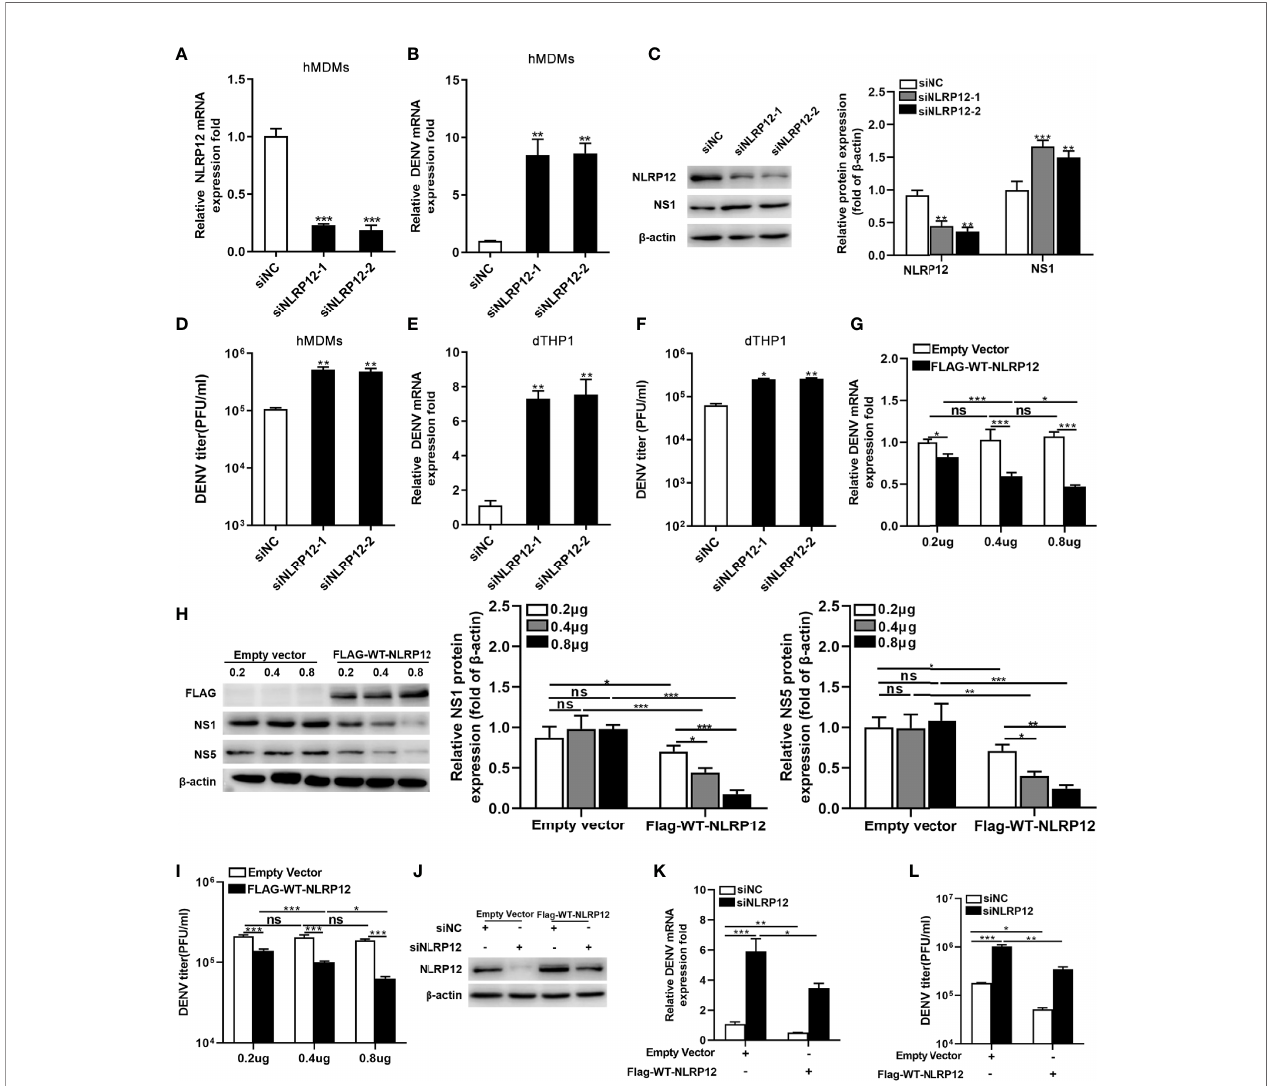
FIGURE 3 | NLRP12 inhibited DENV replication in vitro . (A) hMDMs were transfected with control siRNA or NLRP12 siRNA and the RNA silencing ef fi ciency ofNLRP12 was shown. (B, C, D) NLRP12- silenced hMDMswere infectedwith DENV at a MOI of4 for 48h,after which the DENV genome RNA levelswere detected byqPCR and protein levelsof NS1 were assessed respectively bywesternblot. The gray value ofNS1 proteinbandswas analyzedby Image J gelimage analysis software and the relative grayscalevalue was normalized to that of b -actin. The viraltiter insupernatant was quanti fi ed byplaqueassay. (E,F) dTHP-1 cellswere transfected with control siRNA or NLRP12 siRNA andinfected with DENV at a MOI of 4 for 72h,the DENVgenome RNA and the viraltiter of supernatantwere measured. (G,H,I) dTHP1 cells were transfected with overexpression plasmids of NLRP12 and infected with DENV at a MOI of 4 for 72h, after which the levels of DENVgenome RNA and NS1 andNS5 proteins were detected. The gray value of NS1 andNS5 bandswas analyzed by Image J gel image analysissoftware and the relative grayscalevalue was normalizedto that of b - actin. The viraltiter of supernatant was detected by plaque assay. (J) dTHP1 cells were transfected with Flag-tagged NLRP12 plasmid or empty expression vectorafter which NLRP12 siRNAs were transfected. A portion ofthe cells were harvested for western blot. (K, L) The rest cellswere infected with DENV at a MOI of 4 for 72h,then DENV RNA levels andthe virus titers in supernatants were assessed.Each experiment was repeated a minimum of three times and the statistical signi fi cancewas determined with analysis of one-way analysis of variance (ANOVA).ns, nonsigni fi cant, *P < 0.05, **P < 0.01, ***P <